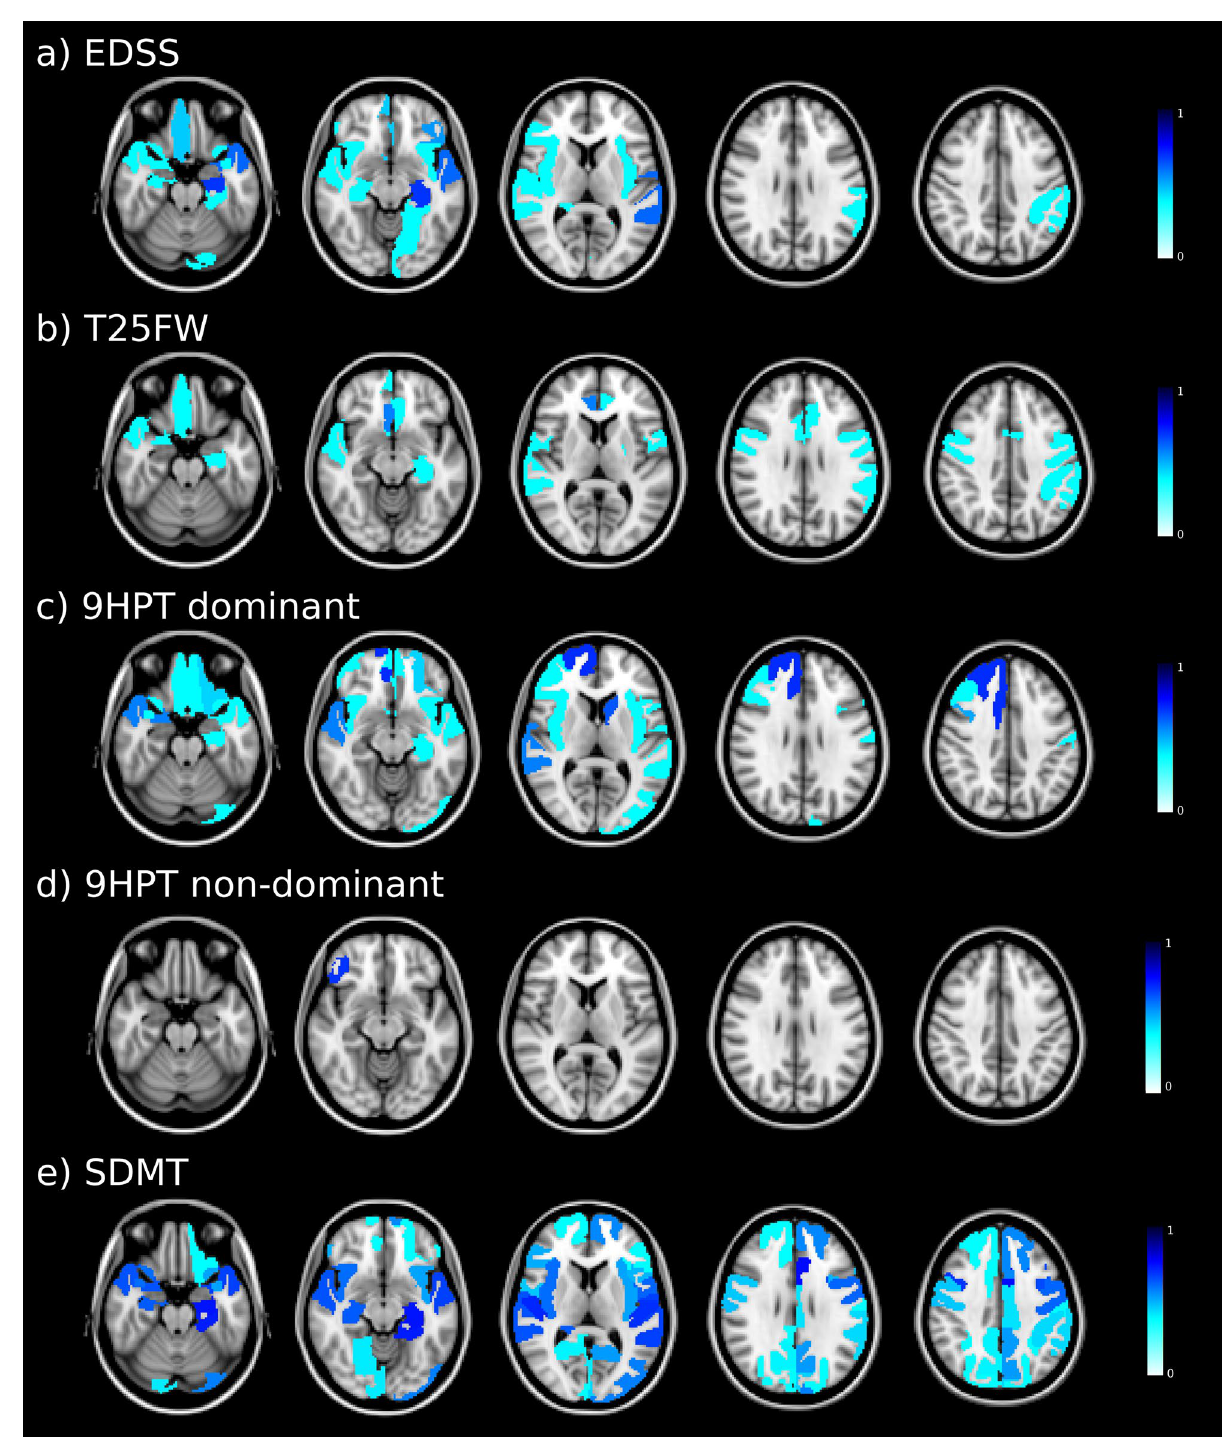
Figure 2. Baseline mean diffusivity maps associated with follow-up disability outcome. Coloured regions indicate areas of significant associations between grey matter mean diffusivity and clinical outcomes. In the colour scale, 1 represents the maximum coefficient value for the association in each outcome. EDSS Expanded Disability Status Scale; T25FW Timed 25-Foot Walk; 9HPT 9 Hole Peg Test; DH dominant hand; NDH non- dominant hand; SDMT Symbol Digit Modalities